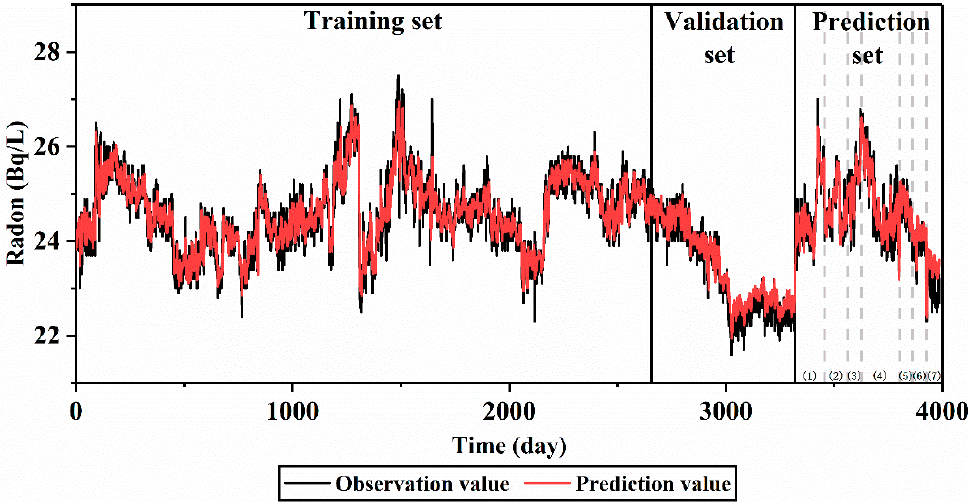
Figure 6. The predicted results of groundwater radon by the EMD-LSTM model, including training set, validation set, and prediction set.